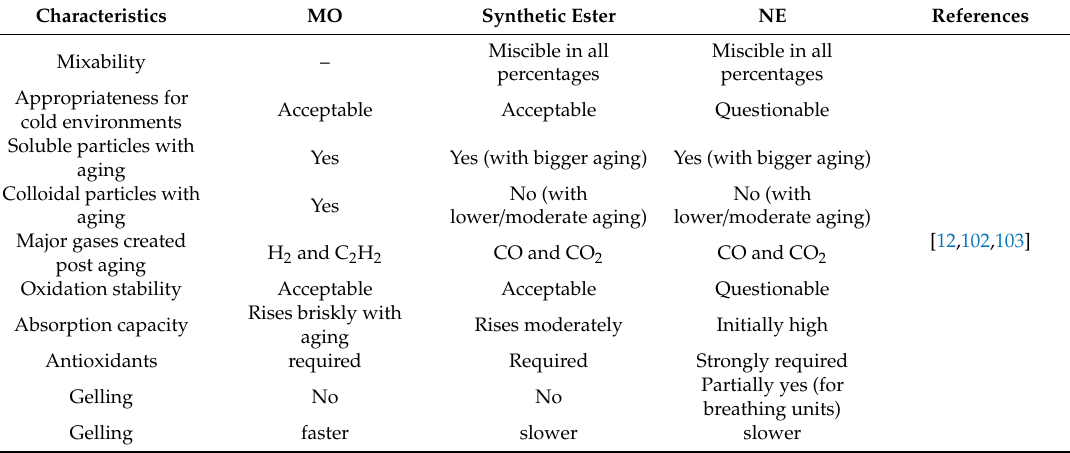
Table 19. Workability observations for various insulating